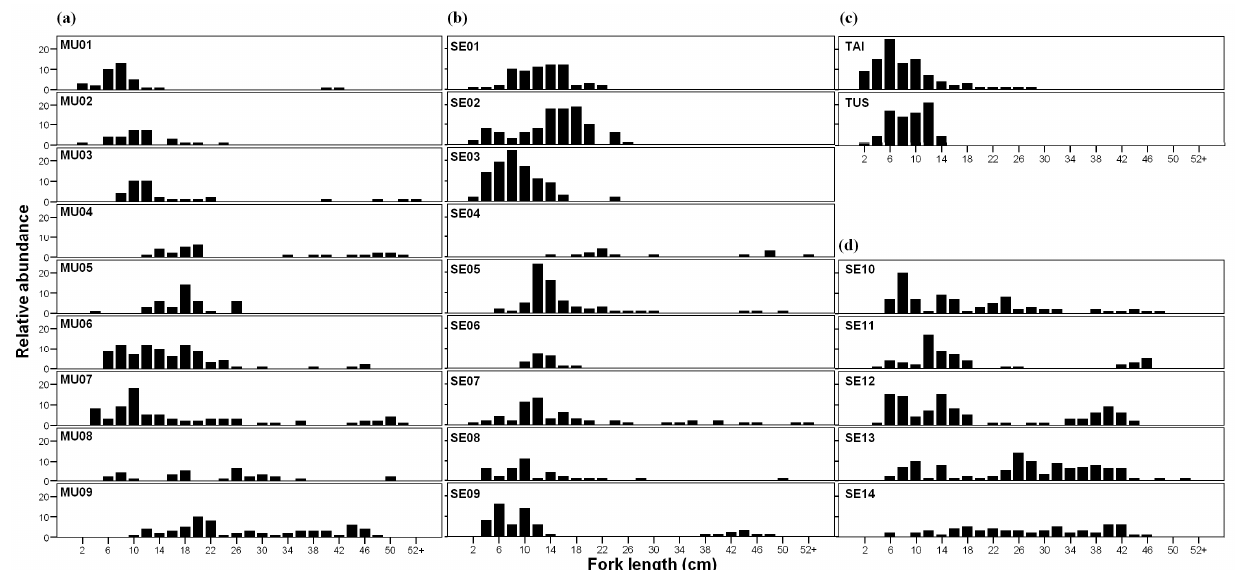
Figure 3. Size distribution (2 cm fork length (FL) groups) of L. sclateri at sampling site. Plot distribution: ( a ) Mundo River (MU) sampling sites, ( b ) sampling sites placed from Segura (SE) riverbed to Mundo River confluence, ( c ) sampling sites at tributaries Tus and Taibilla (TAI) Rivers and ( d ) sampling sites from Segura–Mundo confluence to the latest downstream sampling site (SE14).